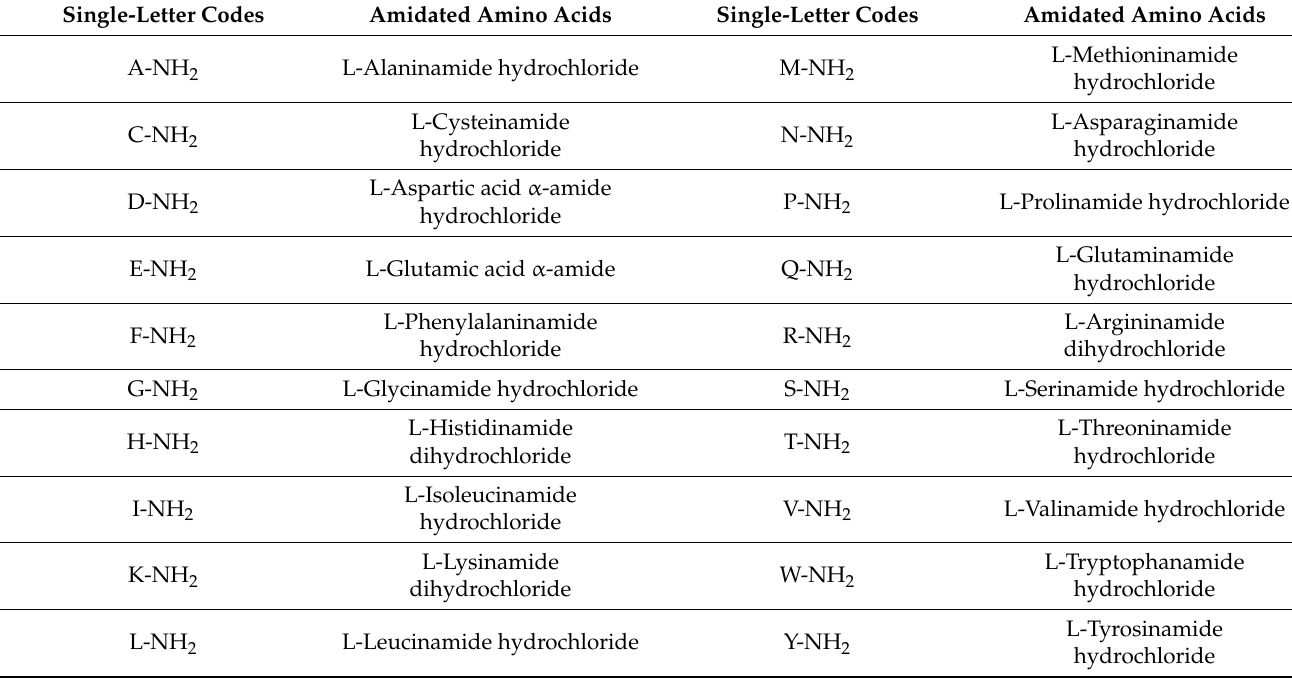
Table 1. Single letter-codes for twenty different amidated amino acids used in this